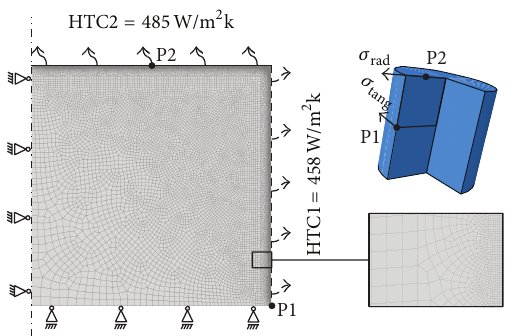
Figure 3: Instrumented heat treatment of a cylindrical specimen (diameter and height are 100mm) in a single chamber vacuum furnace. The process parameters are set to austenitizing for 30 min at 990 ∘ C and quenching at 6 bar gas pressure.